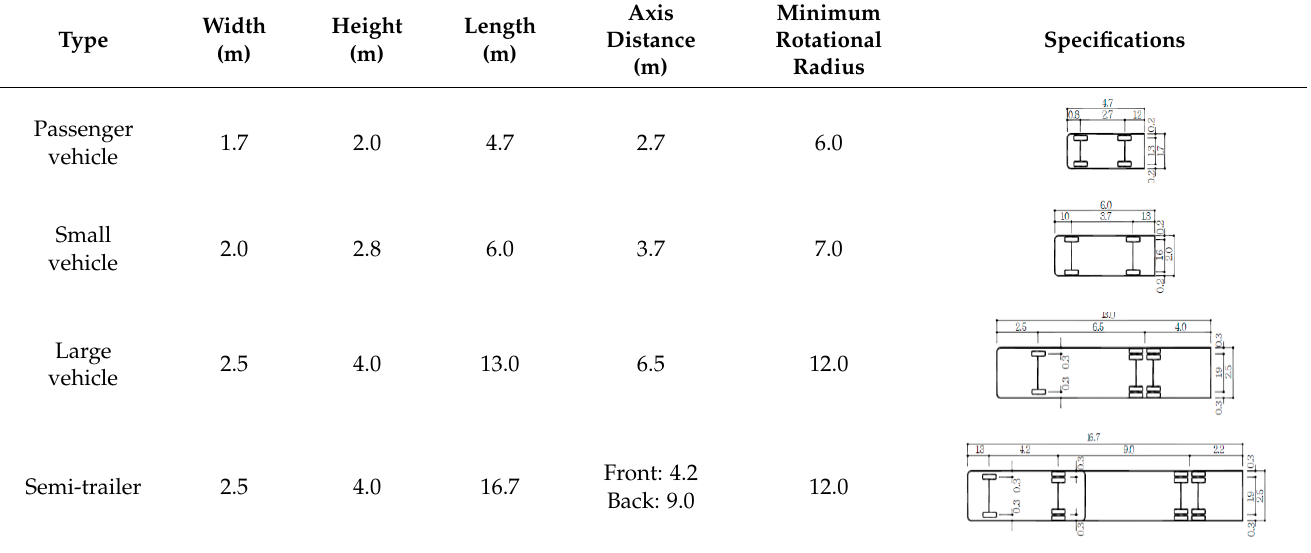
Table 2. Specifications per the design standard automobile type.